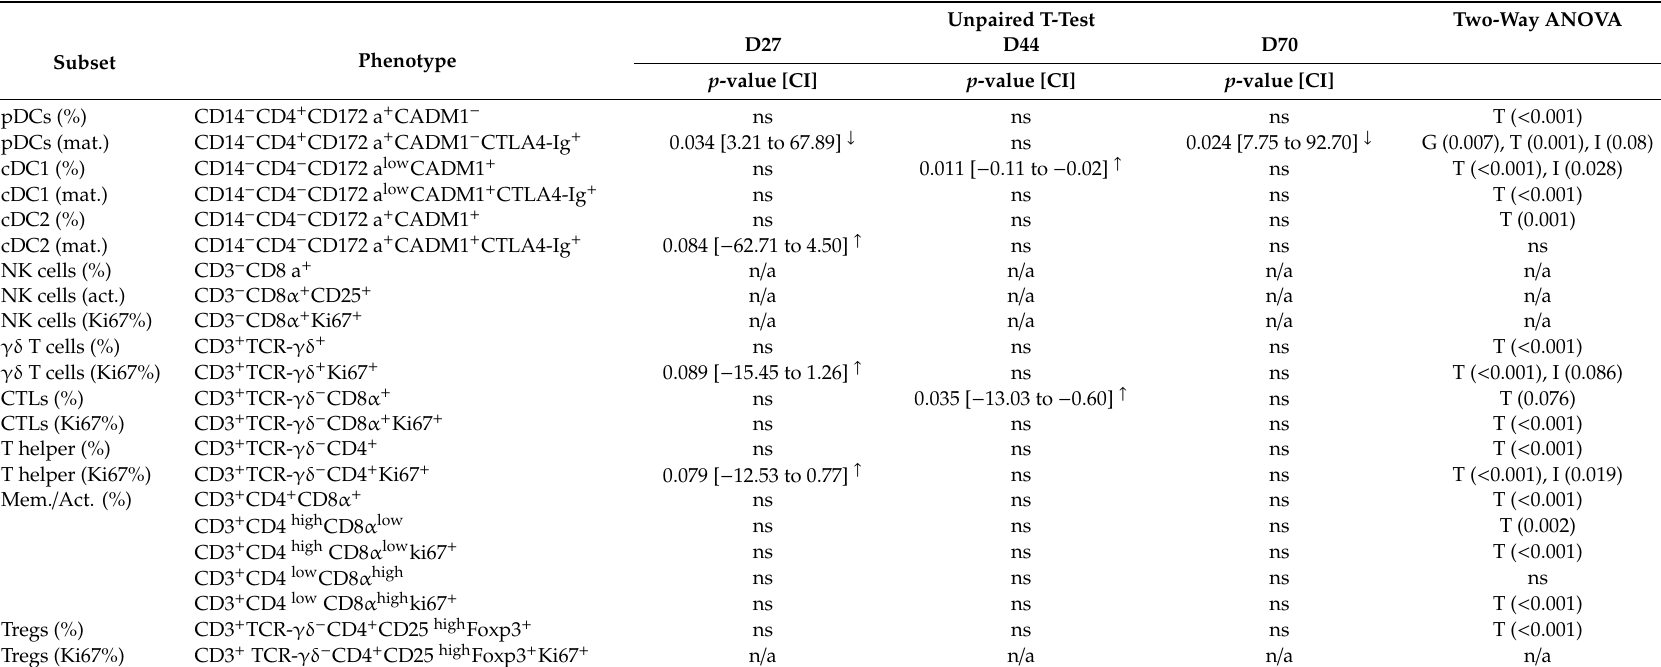
Table 3. Cell analysis of DCs, NK cells and T cells in MLN cells between treatment groups over